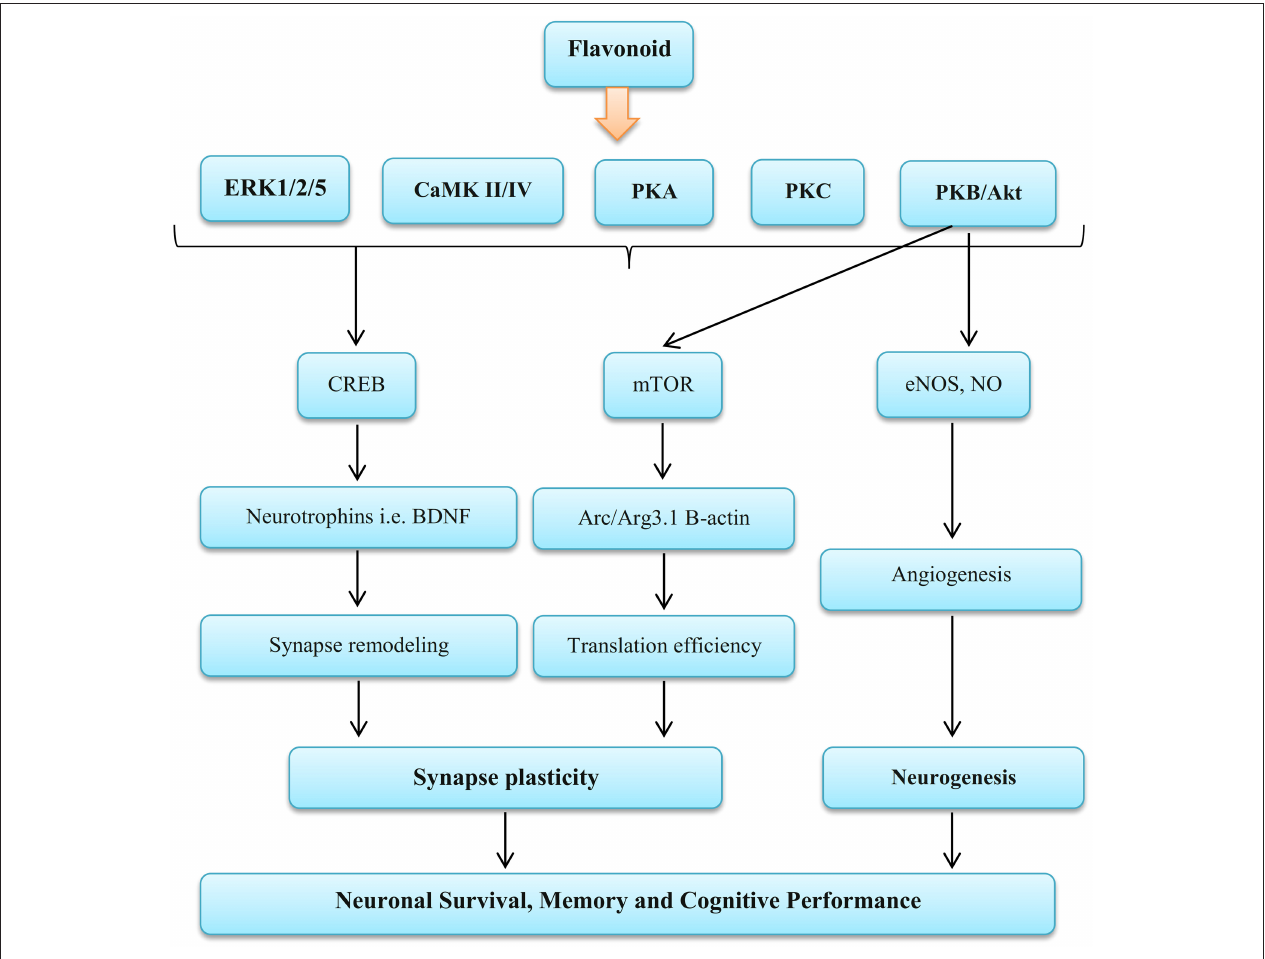
FIGURE 4 | Influence Flavonoid on the nervous function. ERK, Extracellular signal-regulated kinases; CaMK II/IV, Calmodulin-dependent protein kinase II/IV; PKA, Protein kinase A; PKC, Protein kinase C; PKB/AKT, Protein kinase B; CREB, cAMP-response element binding protein; mTOR, Mammalian target of rapamycin; eNOS, Endothelial nitric oxide systems; NO, Nitric oxide; BDNF, Brain-derived neurotrophic factor; Arc/Arg3.1, Activity-regulated cytoskeleton-associated protein. Source: Vauzour et al.